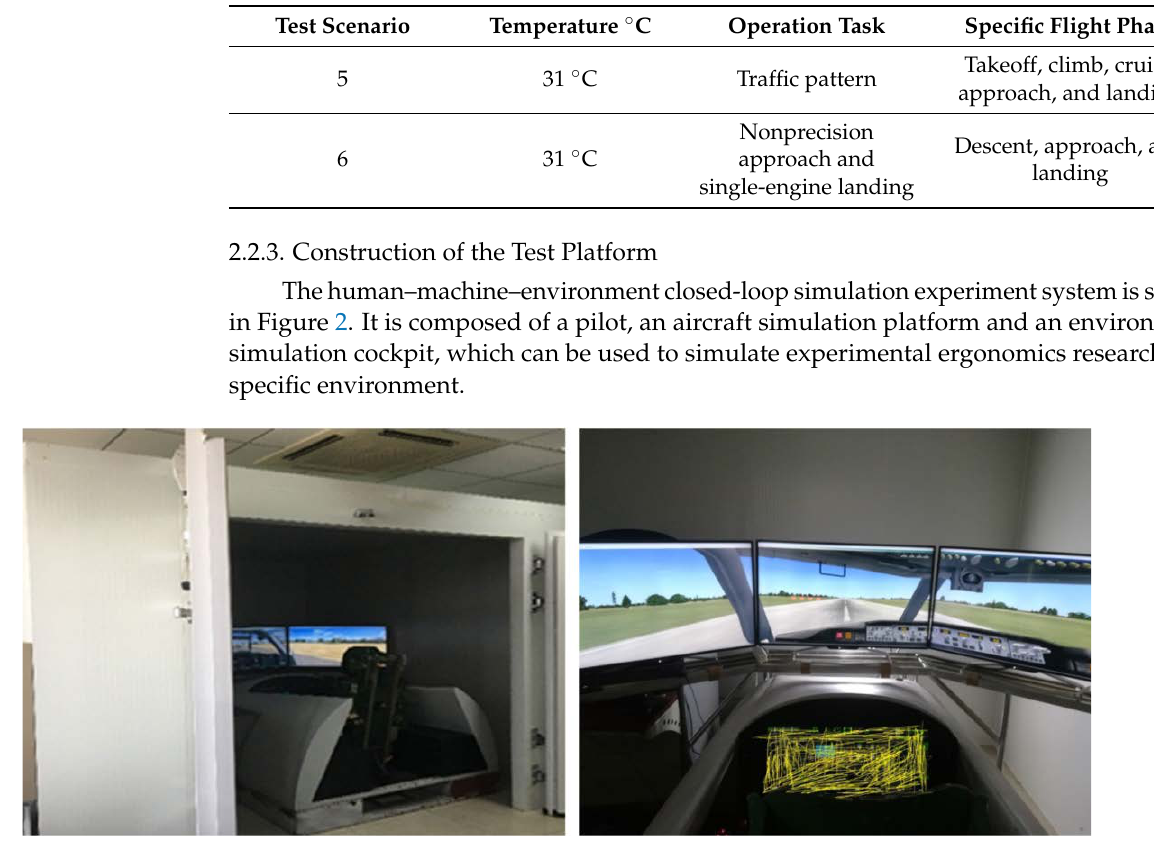
Figure 2. Human–machine–environment closed-loop simulation system.